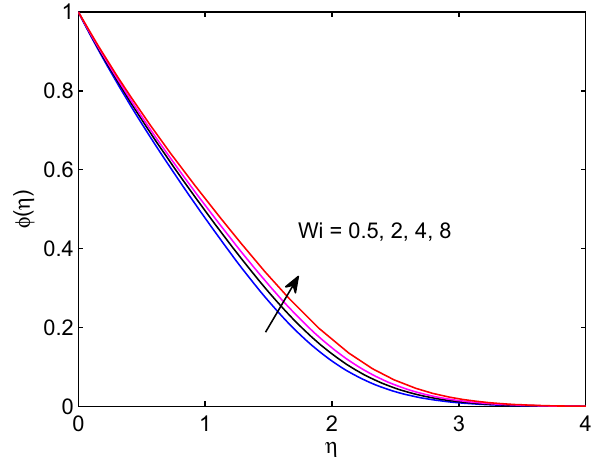
Figure 5. Weissenberg number effects on volumetric concentration profiles.